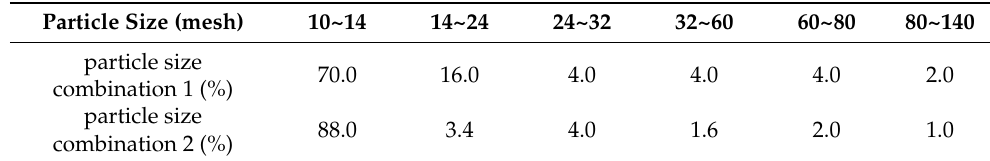
Table 3. The particle size distribution combination used in the experiment.